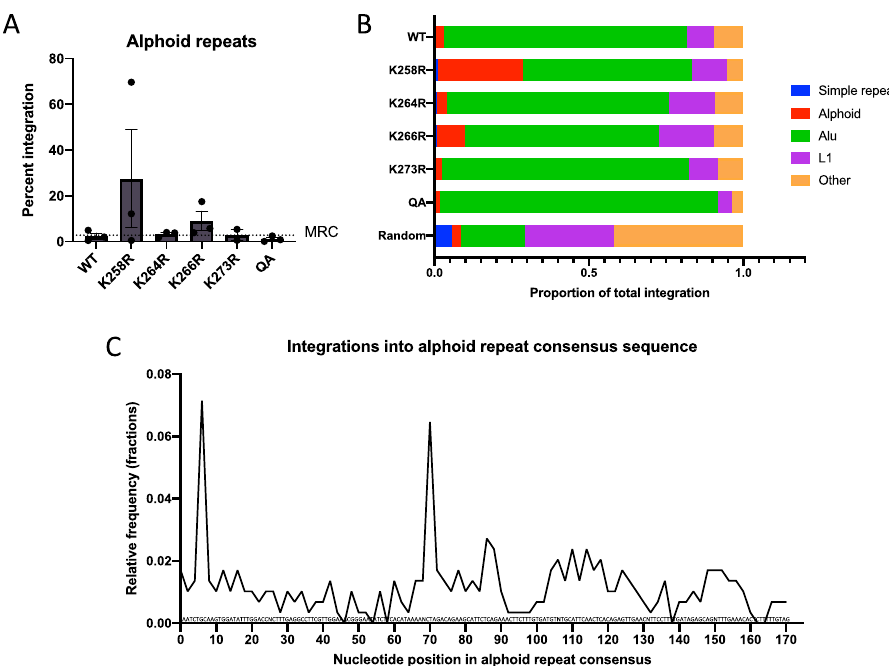
Fig. 4 Mapping of proviral integrations to repetitive regions in the human genome. NGS reads from three independent biological replicate libraries were aligned to the RepeatMasker track from the UCSC genome browser. A The number of integrations mapping to alphoid DNA repeats was determined and normalized to the total number of mapped integrations and is shown as a percent of the total ( n = 3, ±SEs). The frequency with which integrations would be expected to fall in alphoid repeats if integration were random is shown as a dashed line (MRC). B The proportion of integrations that mapped to speci fi c repeat elements relative to the total number of reads that mapped to the RepeatMasker track is shown. Only the most commonly targeted repeat elements are displayed. C Schematic of integration sites along the length of a single alphoid repeat. Unique host sequences immediately fl anking each integration by the K258R mutant IN were aligned to an alphoid repeat consensus sequence (AJ131208.1) using BLAST The consensus sequence was split into bins of two nucleotides and the number of integrations in each bin were counted. Shown are the integration counts falling in each bin summed over three replicates. Source data are provided as a Source Data fi